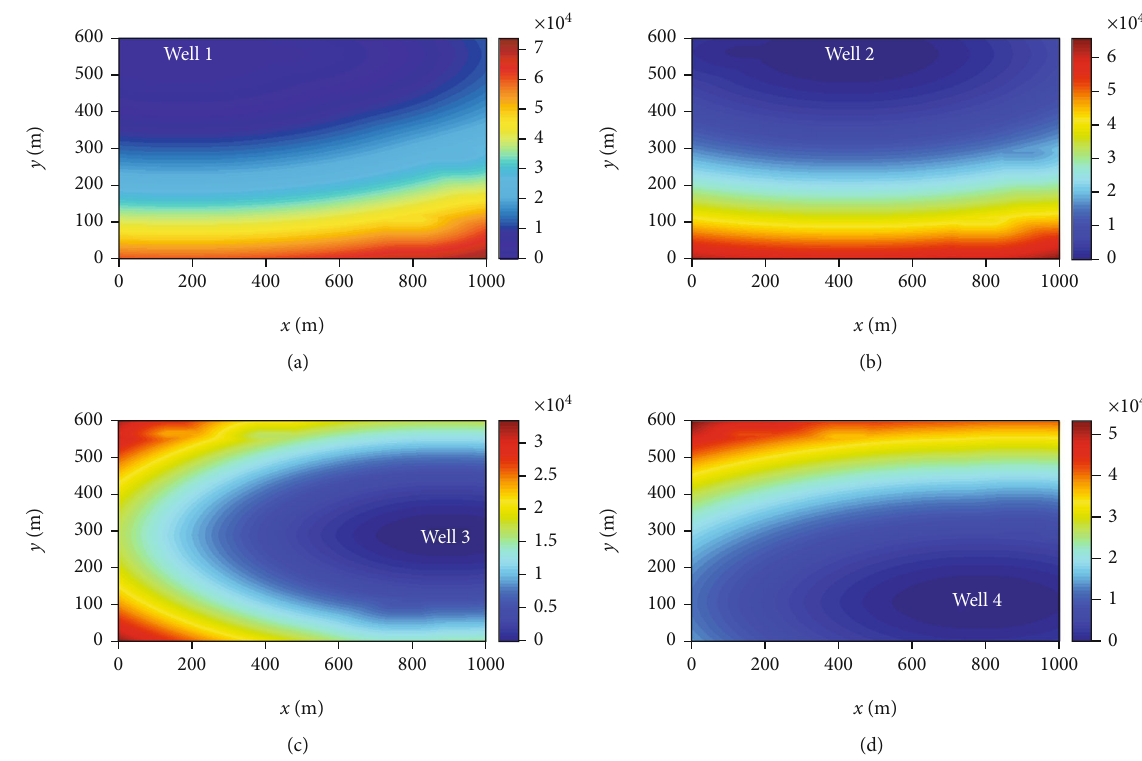
Figure 4: Maps of TOI that are separately calculated with the four fractured wells.